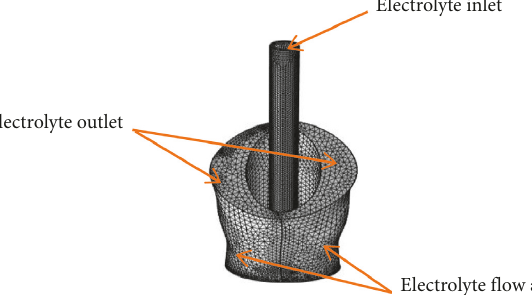
Figure 13: CFD analysis mode of cooling hole (electrolyte encapsulation area).